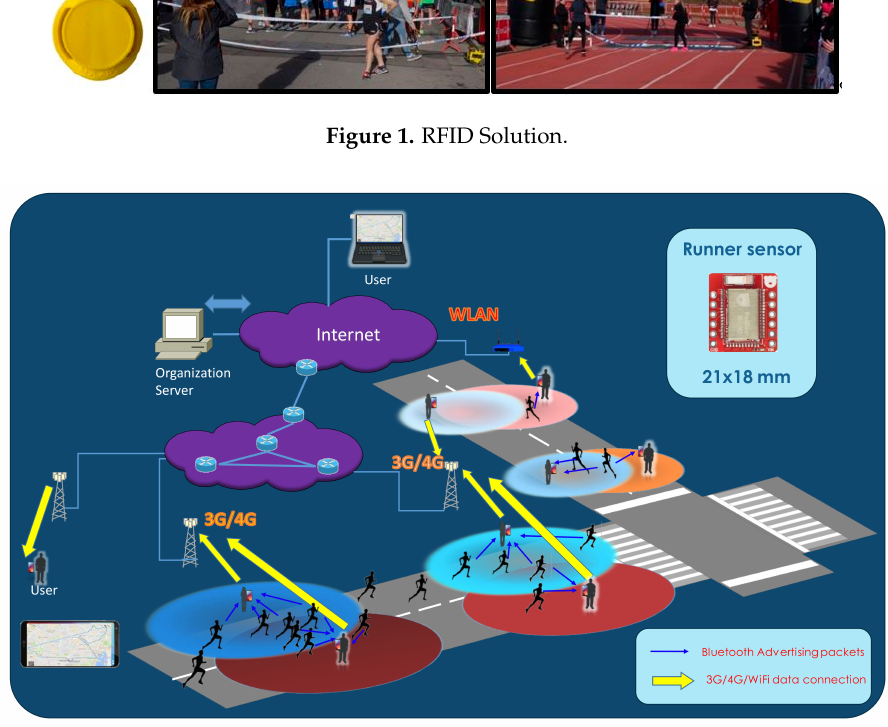
Figure 2. System deployment.